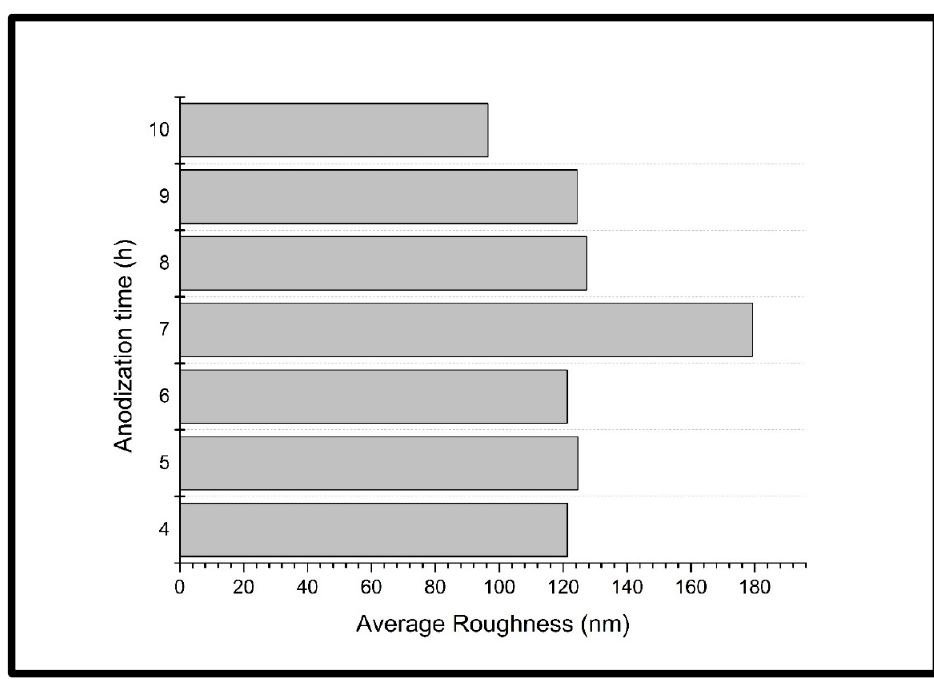
Figure 6. Values of mean roughness (Ra) after anodization process in NH 4 F 0.25% + glycerol at 30 V